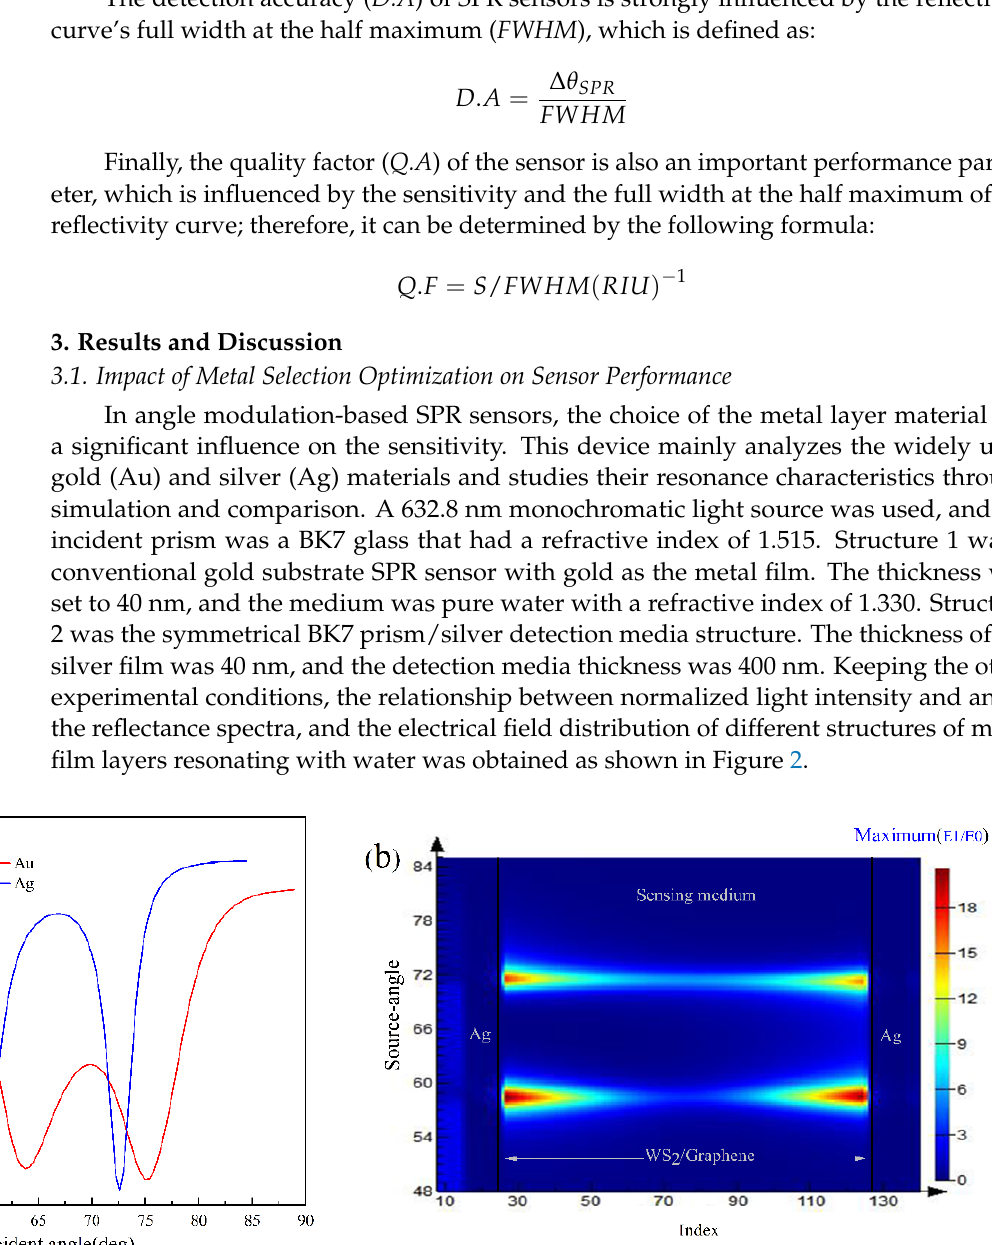
Figure 2. Comparison of reflectance curves and electric field diagrams for symmetrical gold and symmetrical silver films: ( a ) resonance response curves of different metal materials; ( b ) SPR corre- sponding to the electrical field intensity distribution diagrams at a symmetrical structure silver film thickness of 40 nm and detection medium thickness of 400 nm.